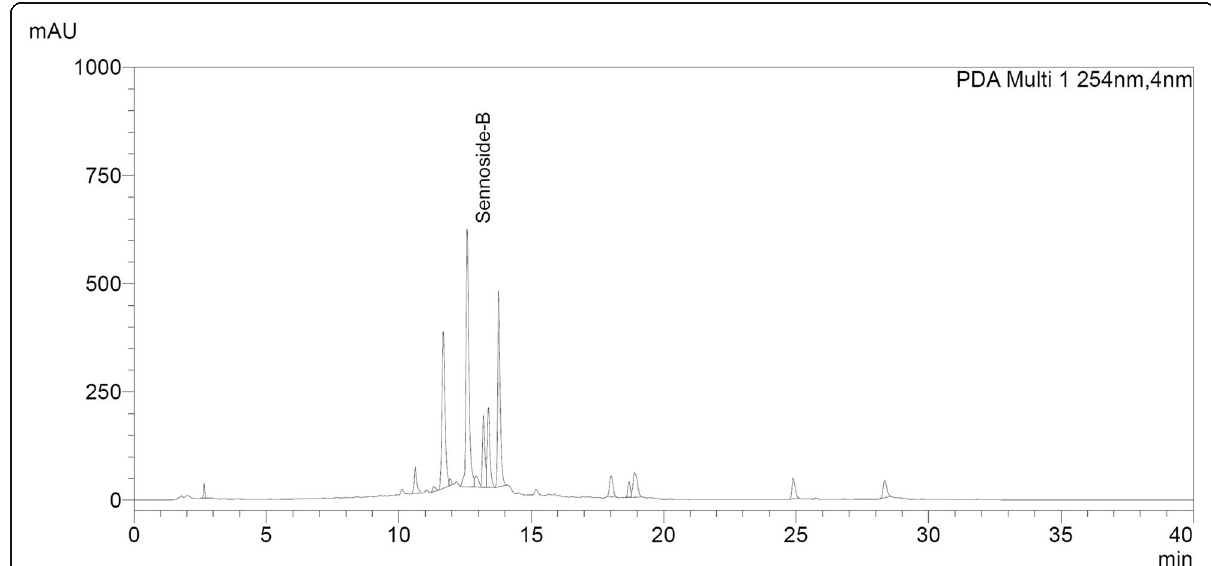
Fig. 4 HPLC chromatogram of Swarnpatri dry